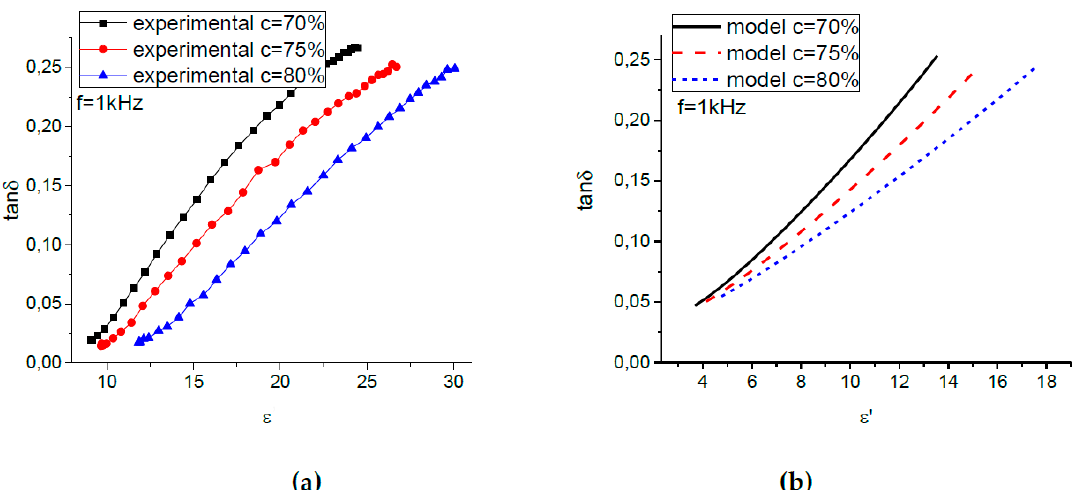
Figure 5. (a) Experimental and (b) model dependence of the dielectric loss tan δ on the relative permittivity ε ´ for MAE samples with different iron concentrations.